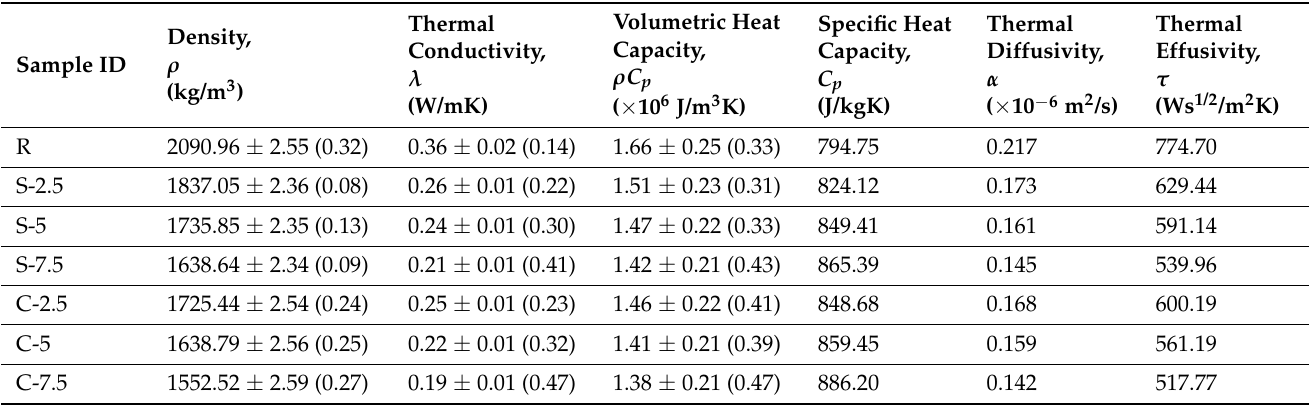
Table 5. Average values and coefficient of variation (% in parenthesis) of thermophysical properties of the sample